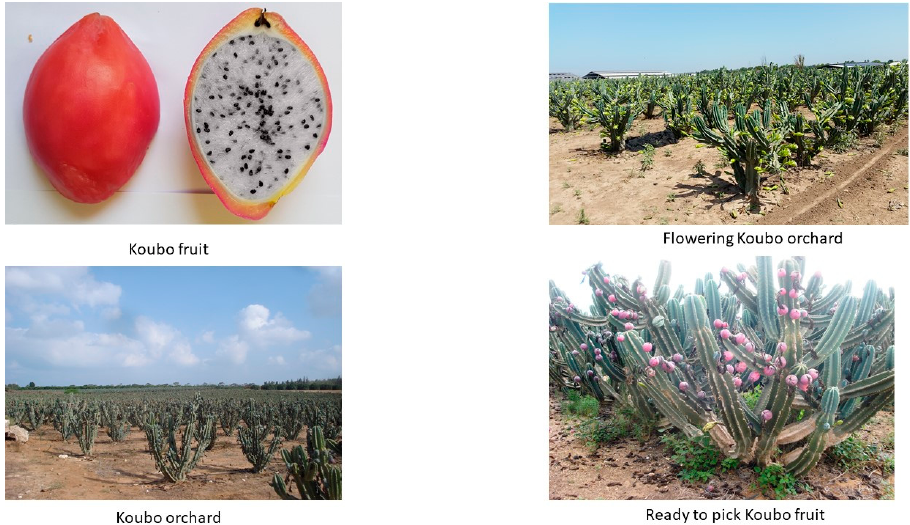
Figure 3. View of Koubo orchard, 4 years old flowering orchard, ripe fruits ready for picking, and open Koubo fruit.